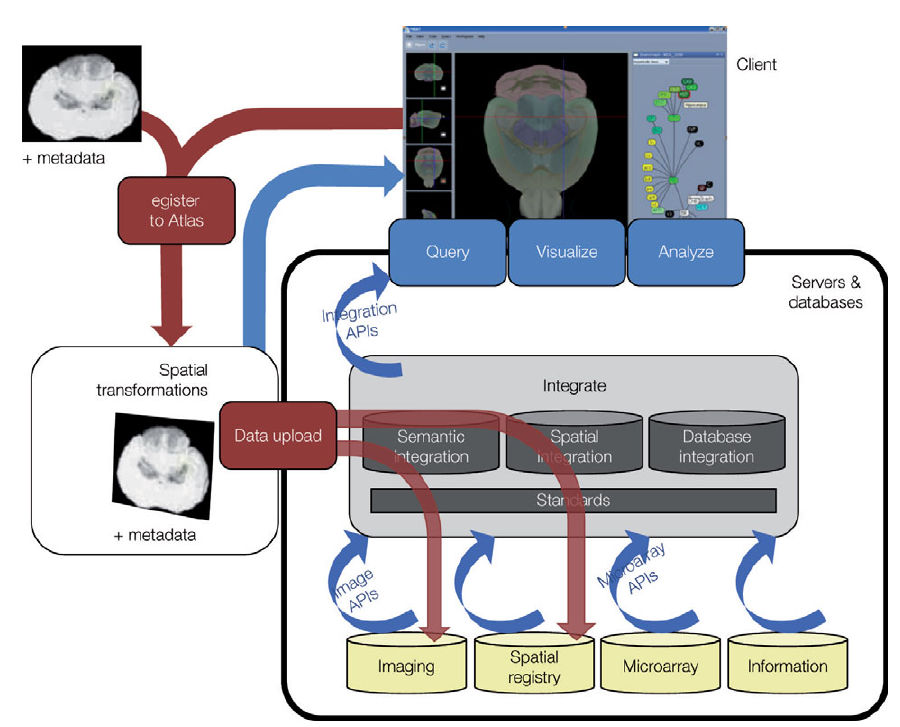
Figure 2 | An extensible and fl exible atlas based framework for data sharing. Data and client are located on a user’s computer. Red describes a workfl ow for data contribution. Gray elements are specialized servers, databases, tools, and standards built by the scientifi c community that facilitate integration of data. Yellow cylinders represent data sources that offer a certain data type (i.e., GeneNetwork and the BIRN Microarray Database are both Microarray databases with services that allow access to their data). Blue describes a path for data retrieval. Standardized application program interfaces (APIs-blue arrows) allow the creation of tools that access services offered by a